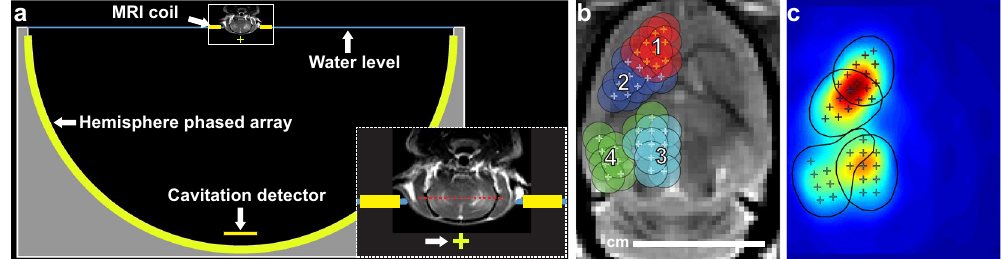
Figure 1. Experimental setup. ( a ) Diagram showing the 30 cm diameter hemisphere phased array with a coronal MRI of the rat head superimposed. The top of the head was partially submerged. A passive cavitation detector was placed near the bottom of the array. The geometric focus (green + ) was approximately 1 cm below the target axial plane in the rat brain (red dotted line in inset). ( b ) Locations of the 36 individual sonication targets in each animal. These spots were targeted over four volumetric sonications, in which the phased array electronically steered the focus to nine targets. The circles indicate a 2.5 mm diameter region around each target that determined the extent of where BBB disruption was measured at the end of the experiments. ( c ) Map of the relative acoustic energy density delivered to the brain, calculated by summing intensity maps simulated for each sonication